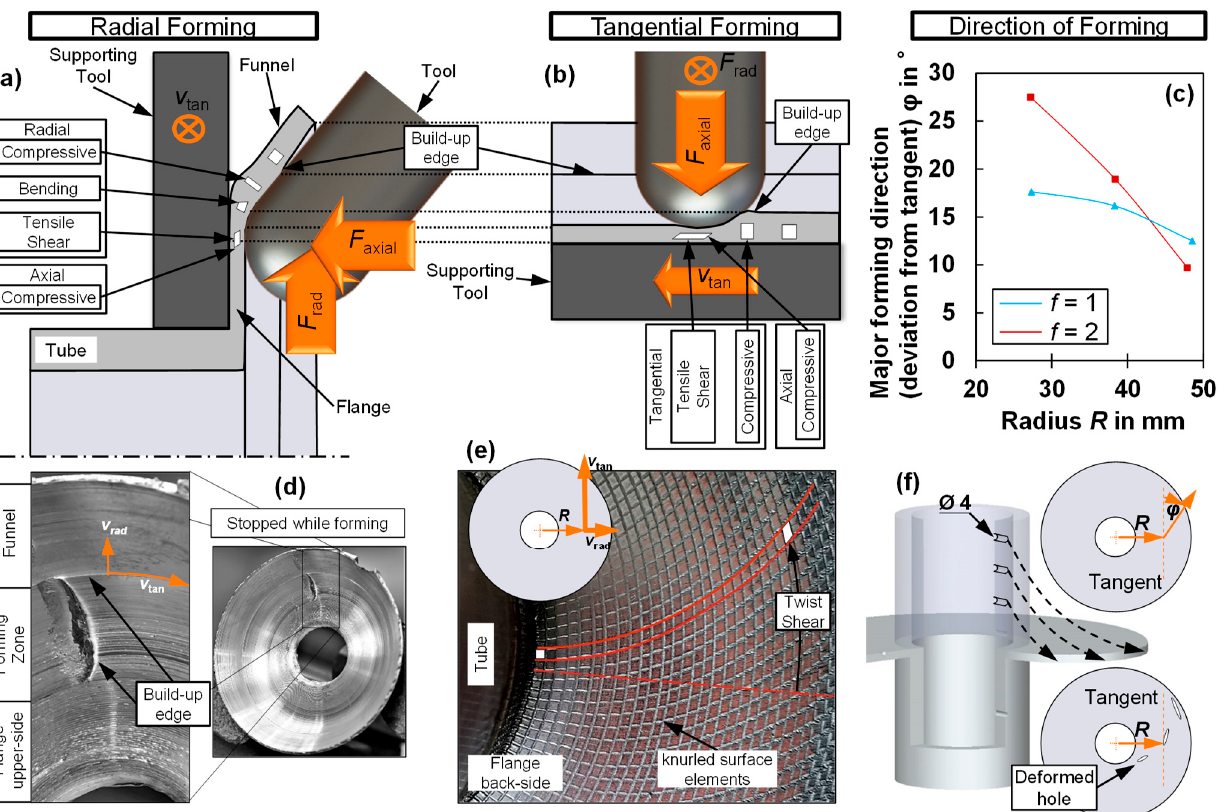
Figure 3. Stress states in the forming zone during the flange-forming phase in the radial, tangential and axial direction. ( a ) Stress states in radial direction, ( b ) stress states in tangential direction, ( c ) direction of forming, ( d ) build-up edge, ( e ) tangential twist, ( f ) experimental setup main forming direction.